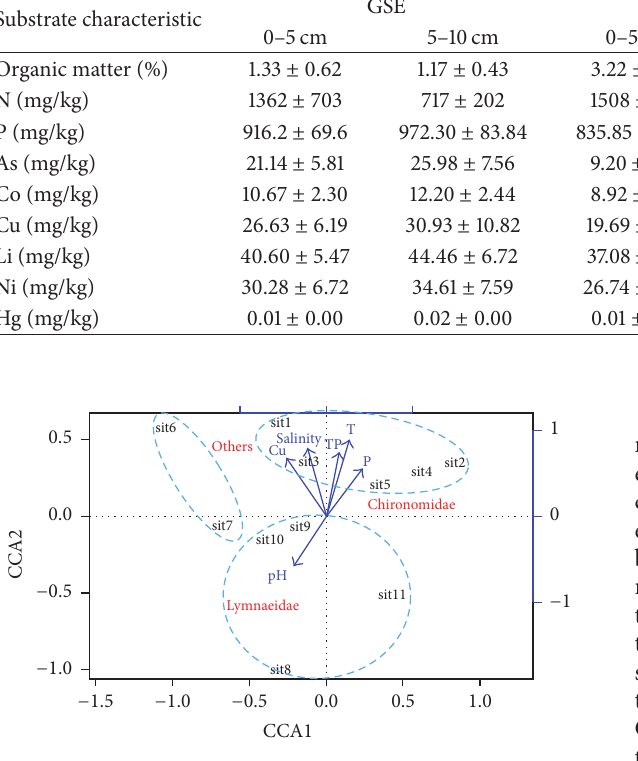
Figure 6: Plot of first two axes of canonical correspondence analysis (CCA) ordination based on the log-transformed benthic macroin- vertebrate density data and environmental variables (arrows) at different sites.